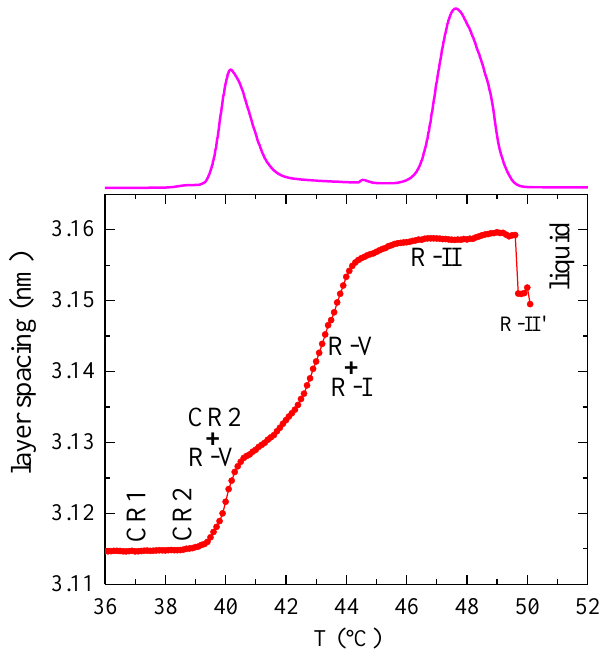
Figure 6. Dependence on temperature of the layer spacing for sample C 23 H 48 . The corresponding DSC heating curve is also shown at the top.